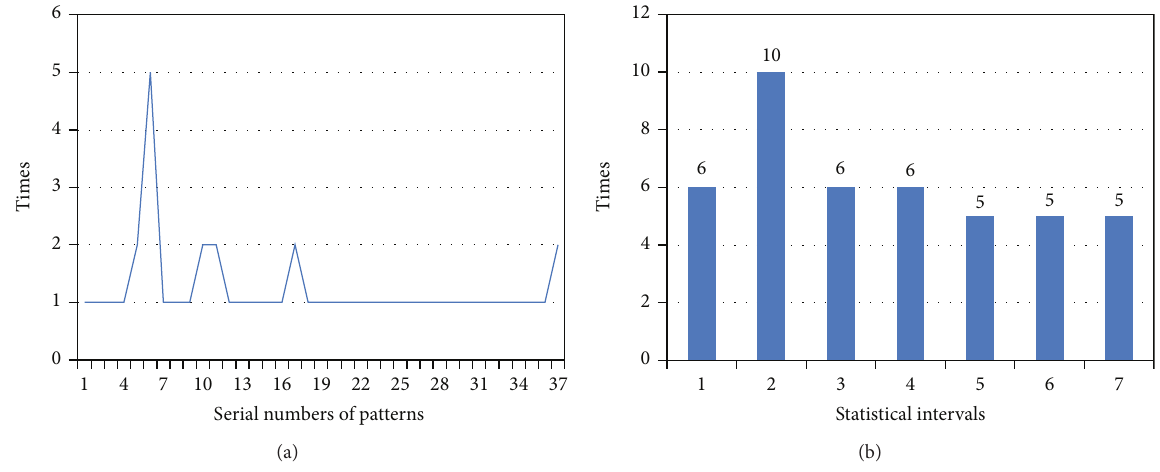
Figure 11: (a) String pattern occurrences waveform; (b) AC matching-histogram information of frame length.